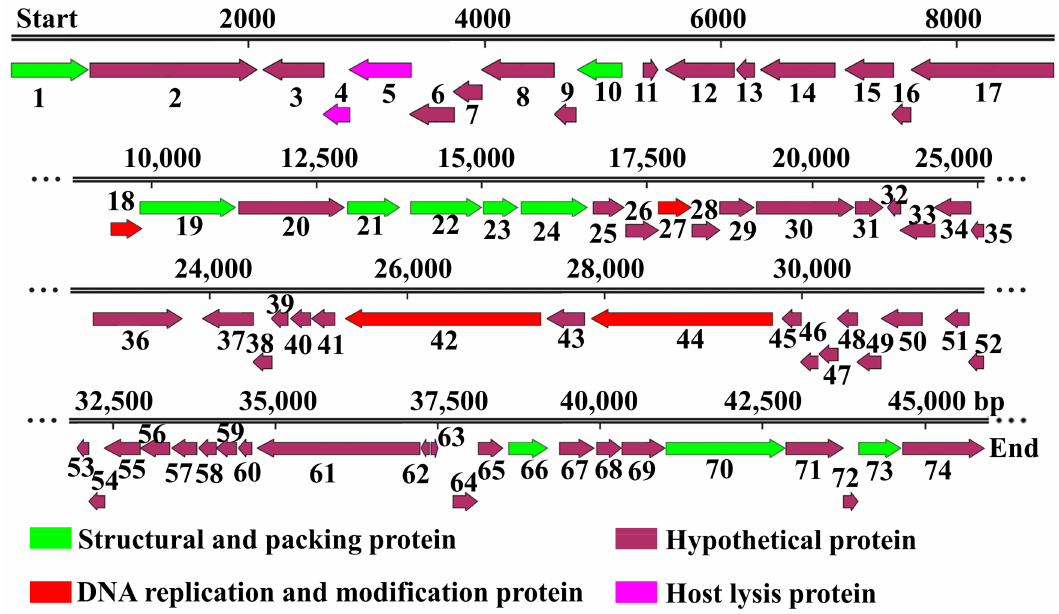
Figure 1. Genome map of phage X2. Double black lines indicate the genome. Numbers above indicate nucleotide position. Block arrows indicate open reading frames (ORFs) and the direction of each read. Each ORF is numbered in running order as indicated by numbers below.